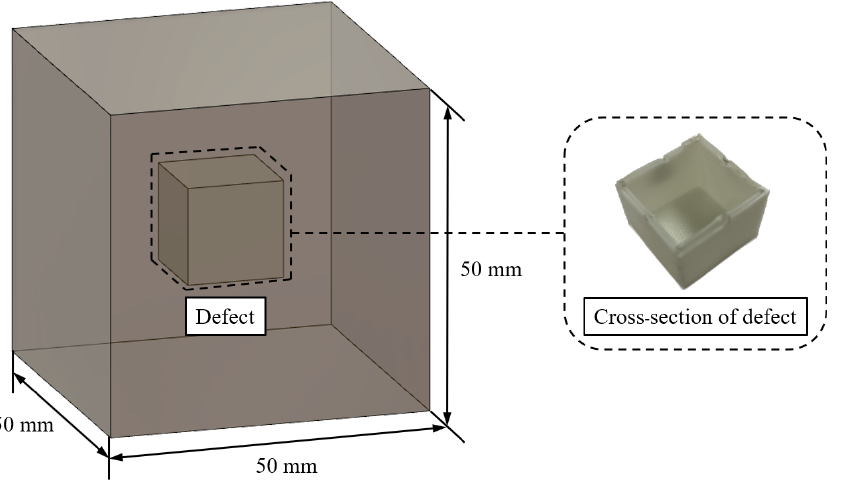
Figure 1. Dimension of nano-cementitious composite for the ultrasonic non-destructive test.